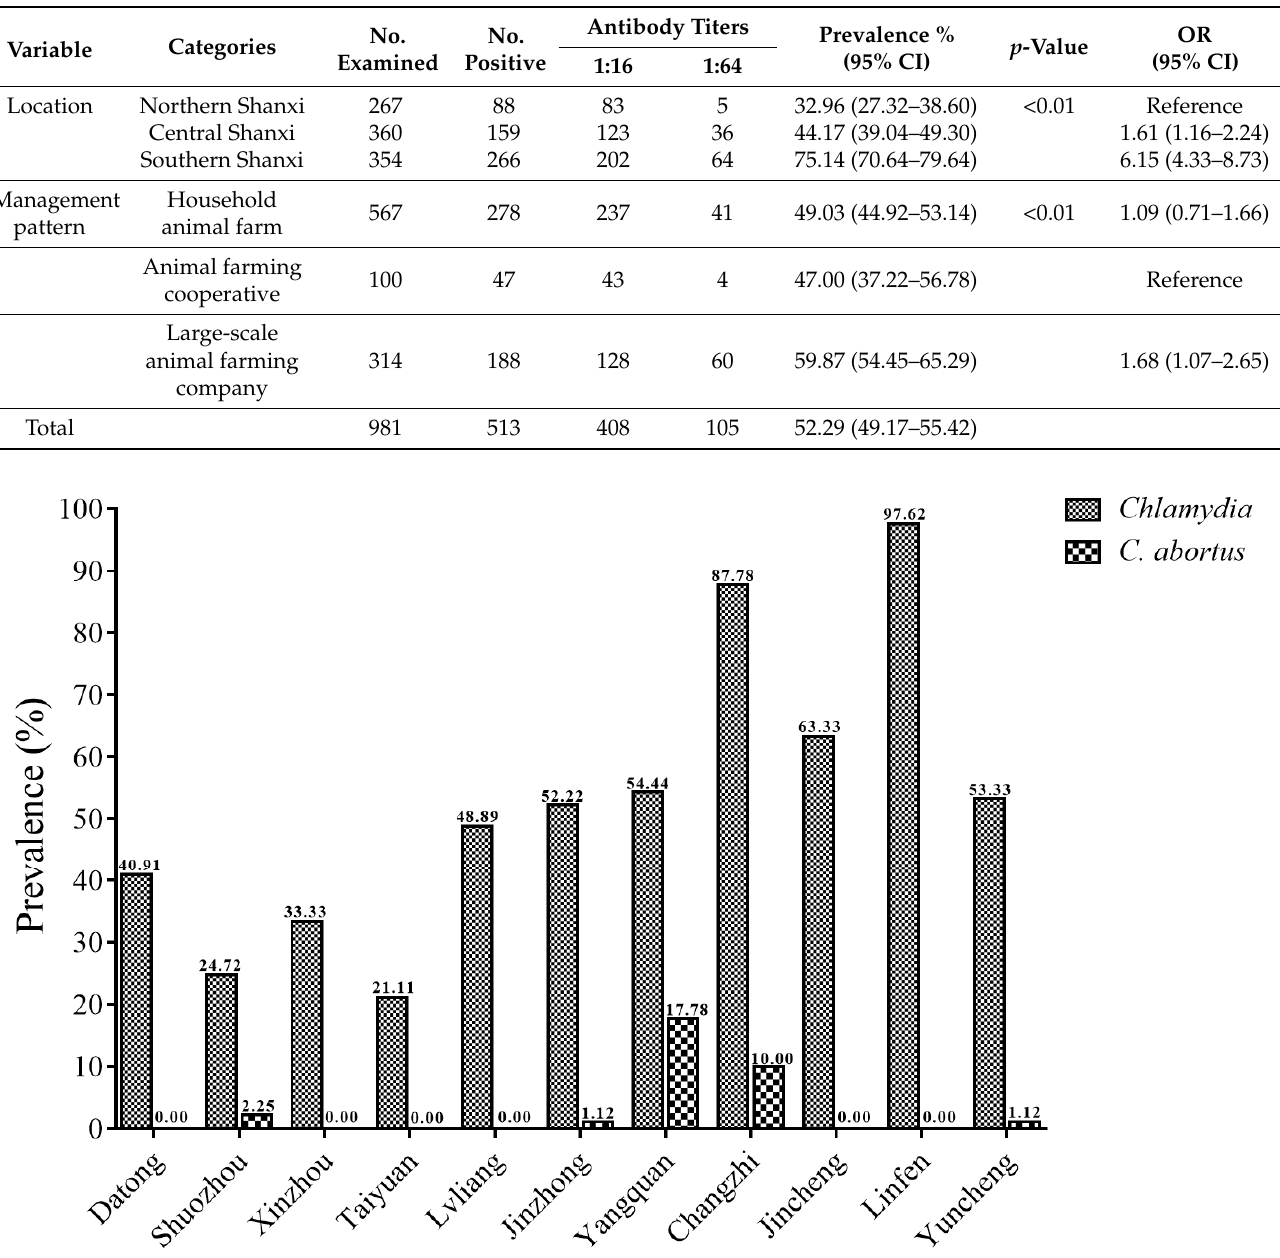
Table 3. Analysis of the related variables of Chlamydia infection in cattle in Shanxi Province.